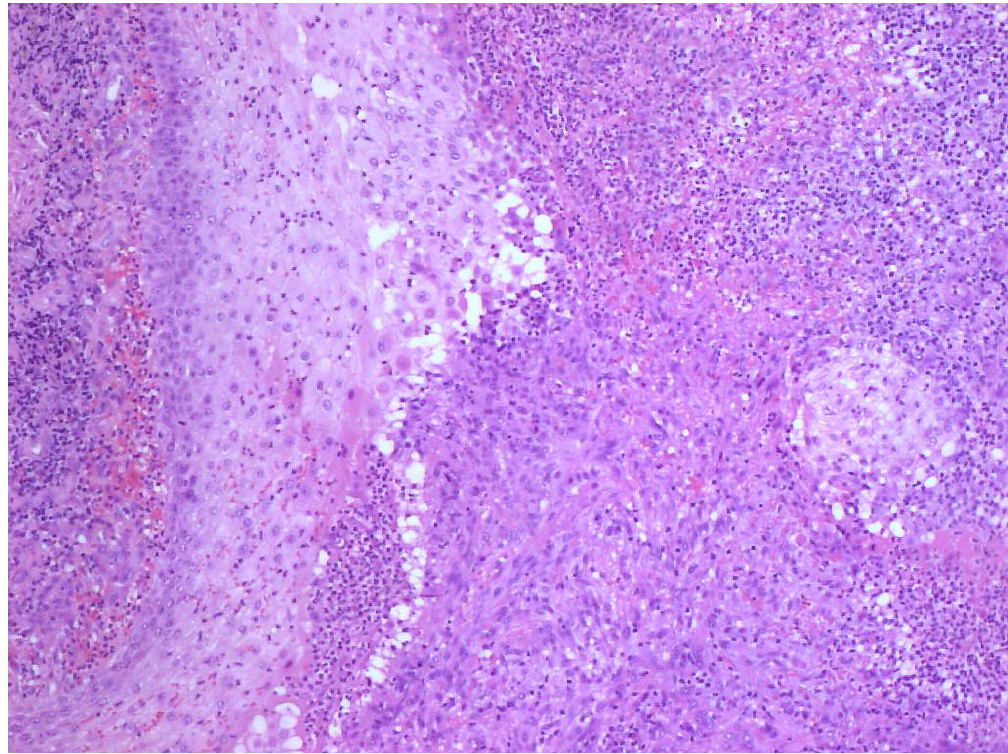
FIGURE 3 . Combination of sinuses, abscesses, and a prominent plasma cell component combined with granulomatous inflammation suggests a diagnosis of